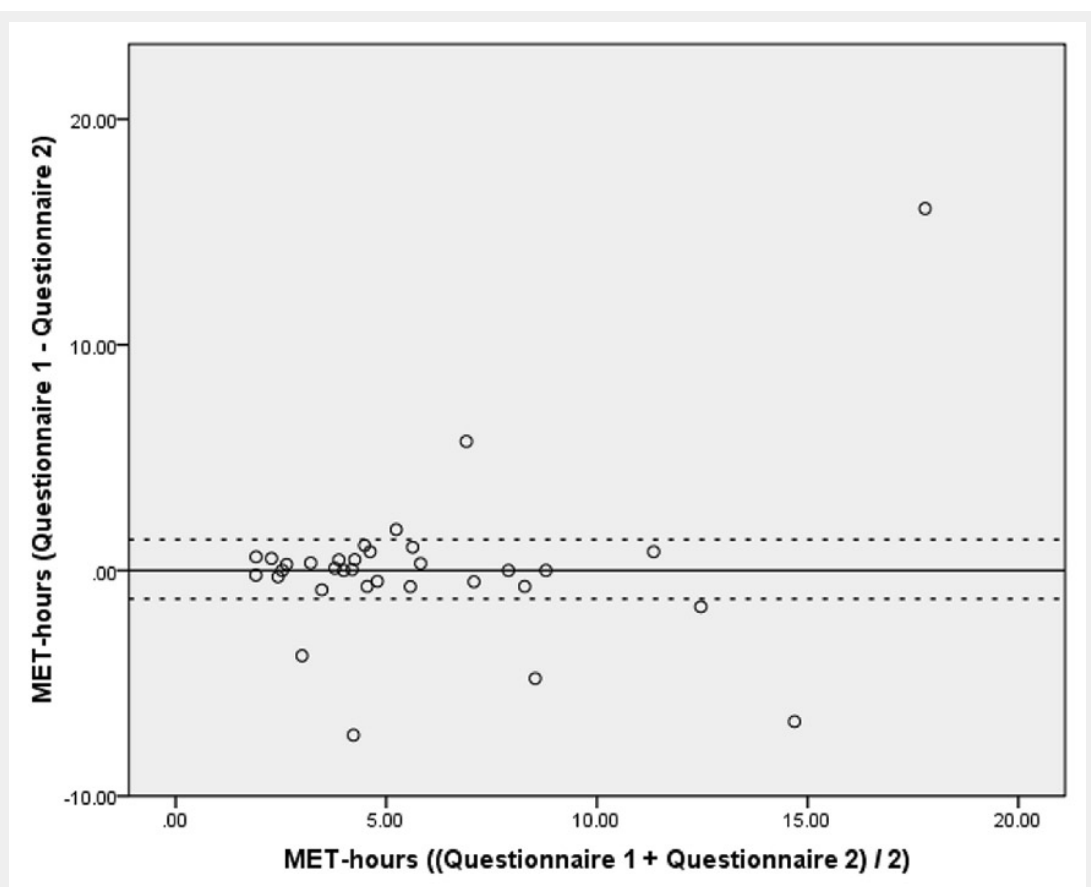
Figure 3 Bland-Altman plot of questionnaire 1 minus questionnaire 2 (vertical axis) against mean of questionnaire 1 and questionnaire 2 measured in MET-hours (horizontal axis). The solid horizontal line corresponds to the mean difference (0.06 MET-hours) while the dashed horizontal lines correspond to the 95% confidence interval (–1.26 to 1.37 MET-hours) (n =